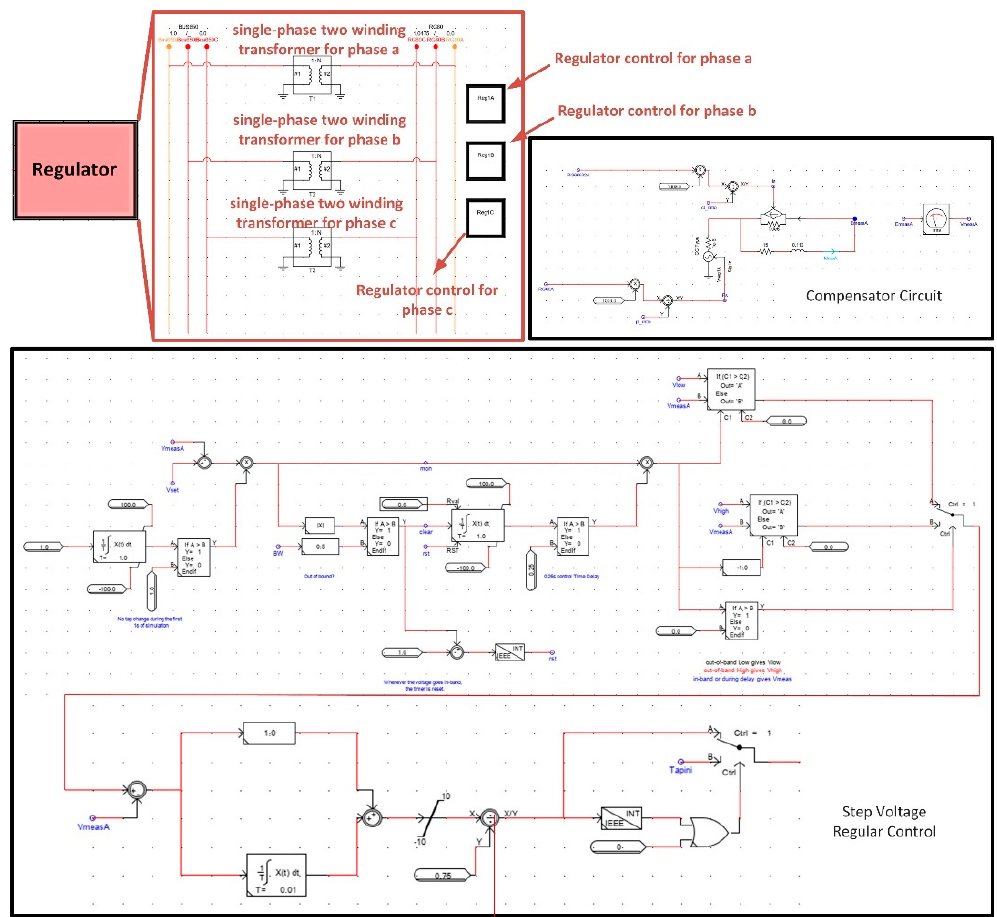
Table 1. Parameters for solar PV system.